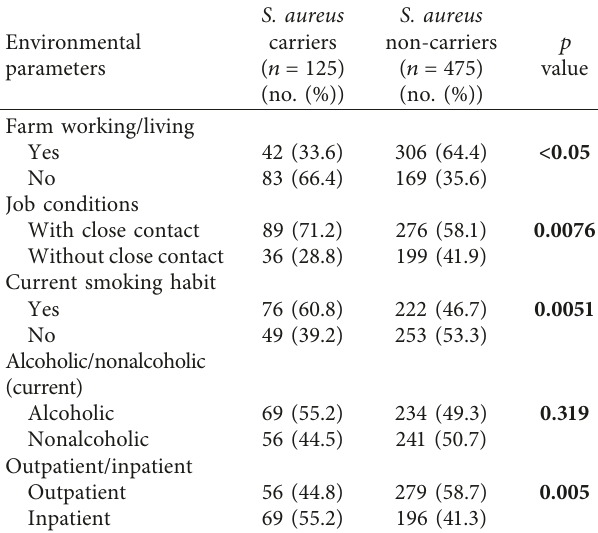
Table 5: Nasal colonization of S. aureus with respect to risk